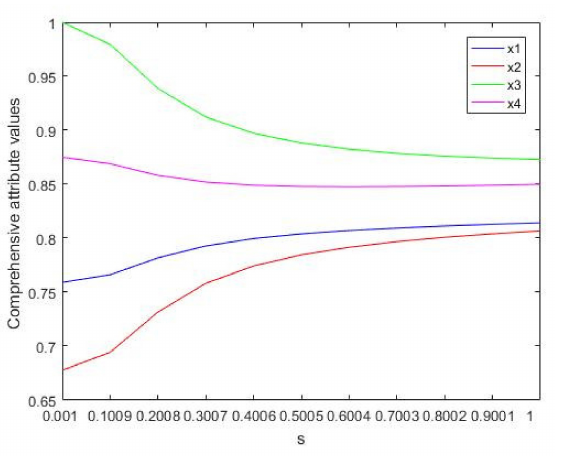
Figure 2. t = 1, s ∈ [ 0.001, 1 ] .